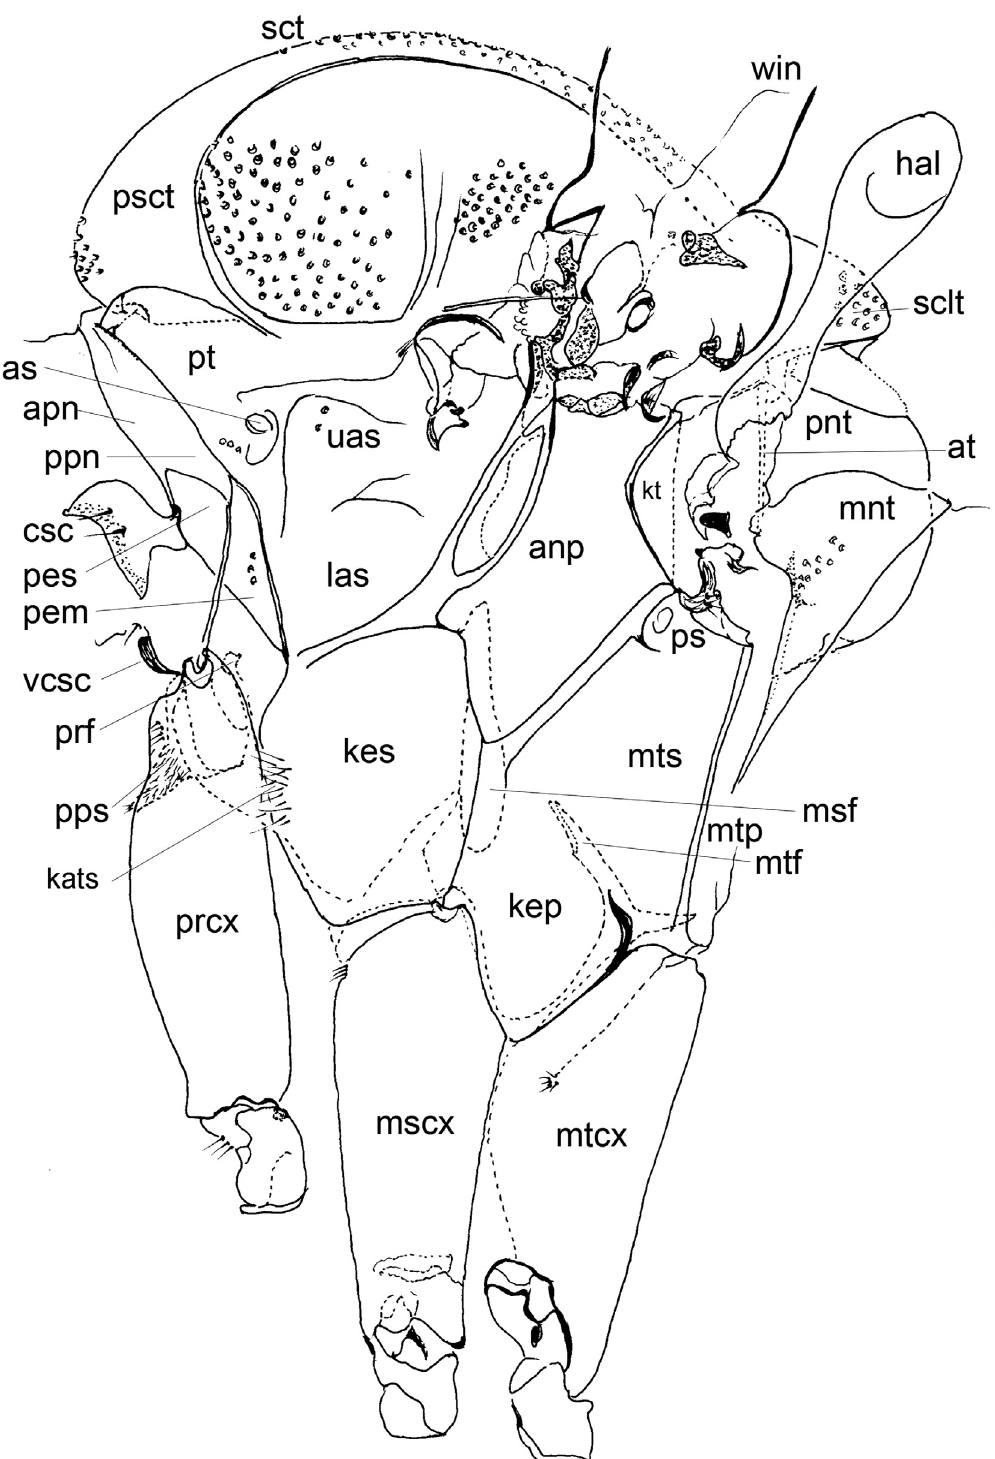
Figure 10. Sclerites of cervix and thorax of Phlebotominae. anp – anepimeron; apn – antepronotum; as – anterior spiracle; at – anatergite; csc – cervical sclerite with a pair of sensilla; hal – halter; kep – katepimeron; kes – katepisternum; kt – katatergitum; las – lower anepisternum; mnt – metanotum; mscx – mesocoxa; msf – mesofurca; mtcx – metacoxa; mtf – metafurca; mtp – metepimeron; mts – metepisternum; pem – proepimeron; pes – proepisternum; pnt – postnotum; ppn – postpronotum; pps – protuberance of the prosternum; prcx – procoxa; prf – profurca; ps – posterior spiracle; psct – prescutum; pt – paratergite; sclt – scutellum; sct – scutum; uas – upper anepisternum; vcsc – ventrocervical sclerite; win – wing. Deanemyia samueli